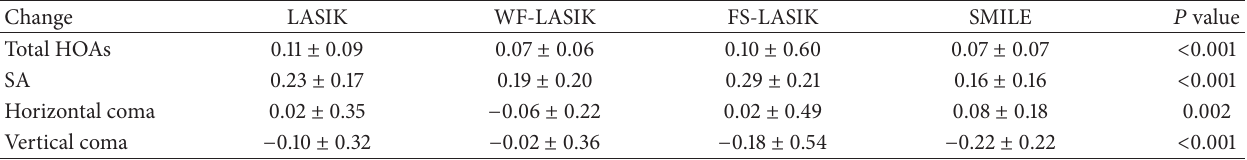
significantly different changes between WF-LASIK and FS- LASIK in terms of vertical coma ( 𝑃 = 0.015 , Figure